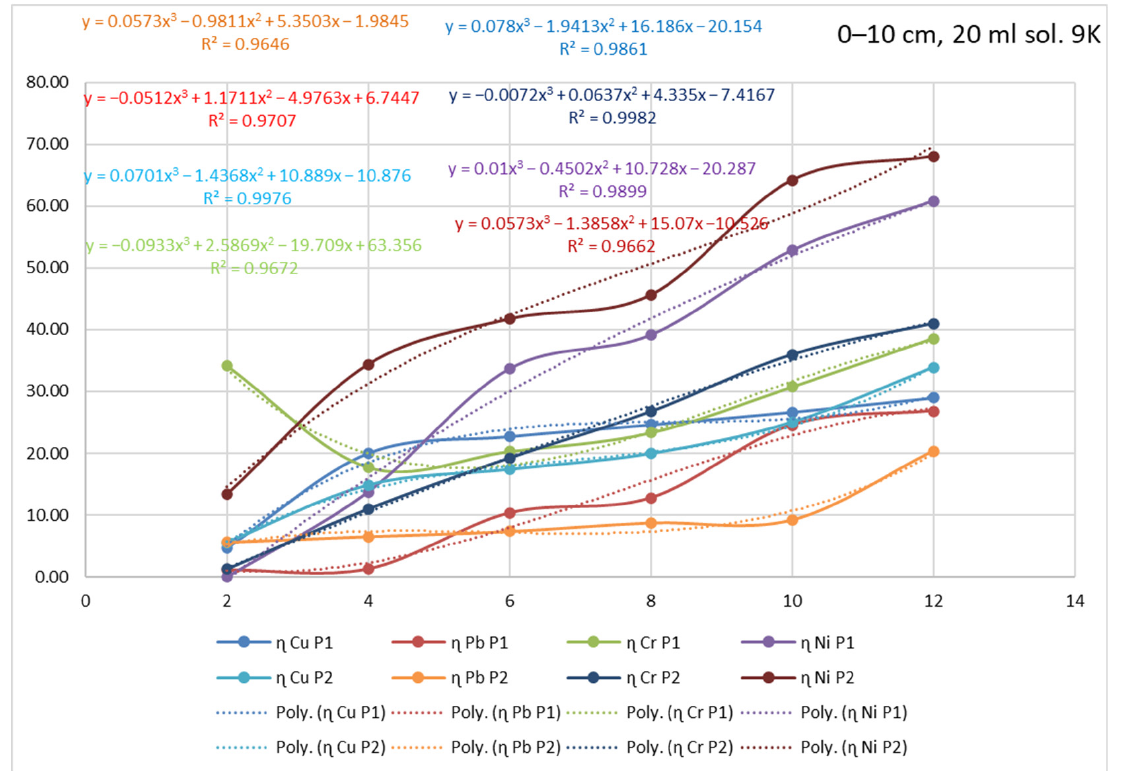
Figure 15. Identification of equations and yield–time correlation indices for P1 and P2 samples taken from 0–10 cm depth and treated with 20 mL of 9K medium.